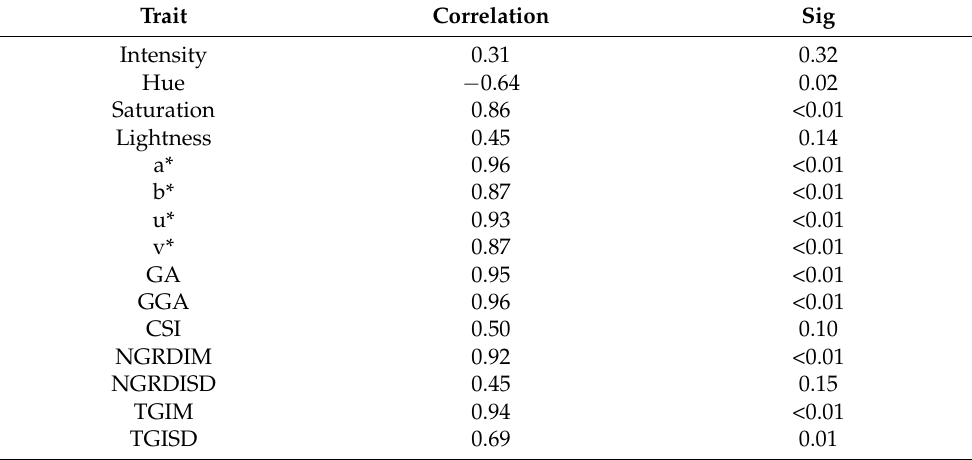
Table 3. Correlation of spectral traits between 2 July 2018 and 28 June 2019.